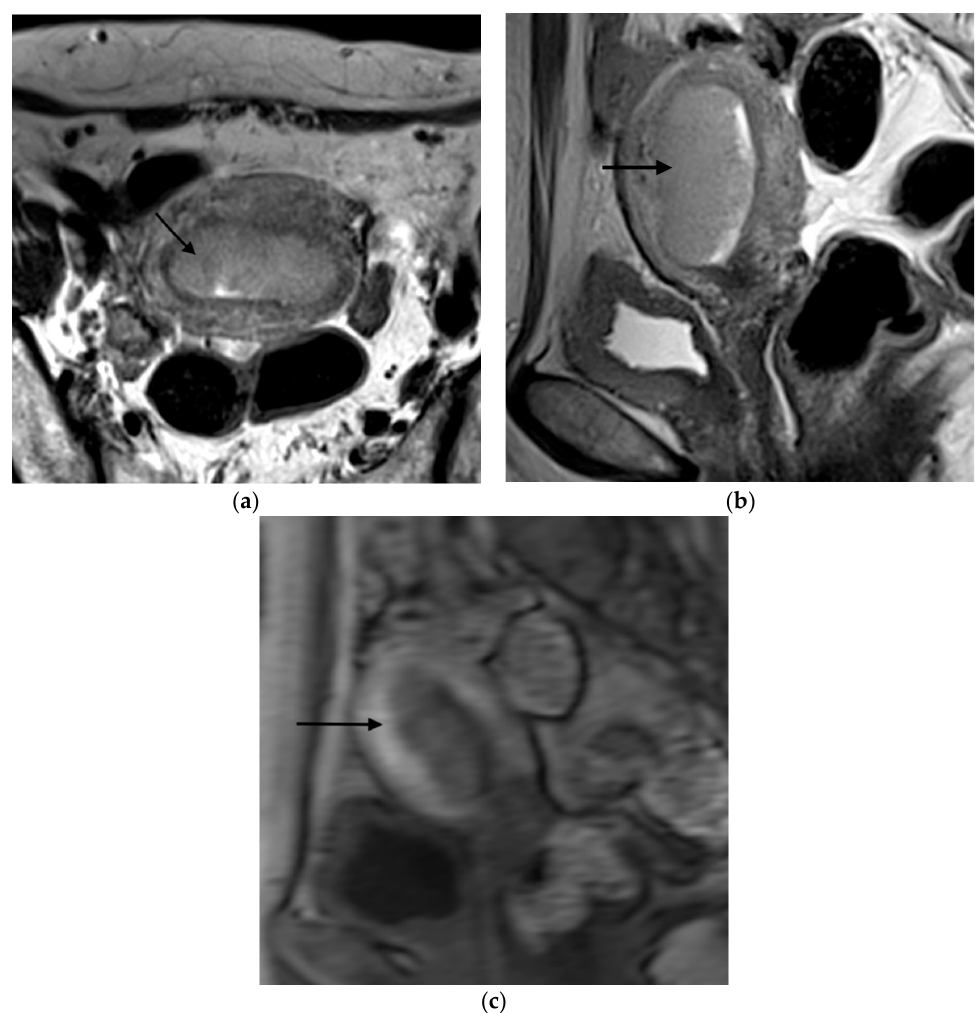
Figure 1. Representative MRI images of endometrial carcinoma with <50% myometrial invasion. ( a ) Axial T2WI, ( b ) sagittal T2WI, and ( c ) sagittal DCE-MRI images during the early acquisition stage. Tumors (arrow) with <50% myometrial invasion presented as iso- to mildly hyperintense on T2WI compared to the myometrium ( a , b ) with an intact junctional zone. On DCE-MRI, the tumors appeared as hypointense masses compared to the adjacent myometrium with intact subendometrial enhancement (SEE), indicating a tumor that is confined to the endometrium ( c ). Abbreviations: MRI, magnetic resonance imaging; dynamic contrast-enhanced magnetic resonance imaging (DCE-MRI); T2WI, T2-weighted imaging.